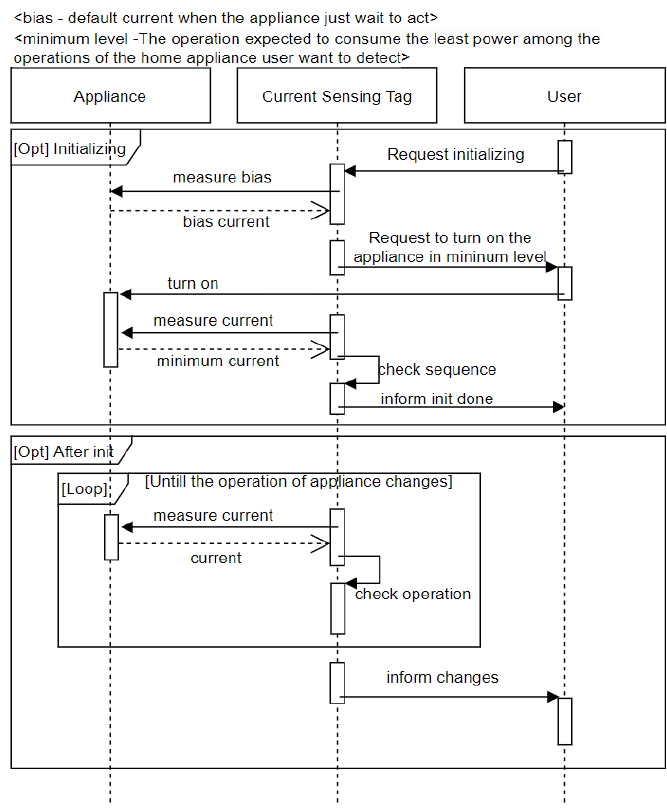
Figure 14. Event sequence of Current Sensing Tag.